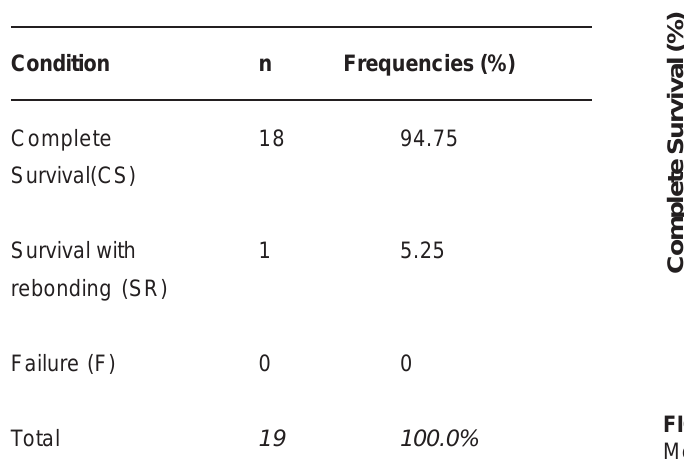
TABLE 3- Clinical situation of the evaluated FDPs